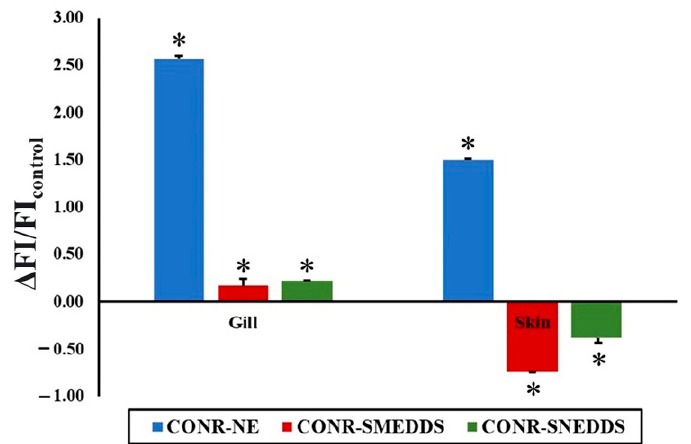
Figure 2. Fluorescence microscopy images of CONR-EtOH ( A ), CONR-NE ( B ), CONR-SMEDDS ( C ), and CONR-SNEDDS ( D ) accumulated in external and internal organs of transparent zebrafish: head (1), gill (2), gill filament (3), skin (4), and brain (5). These illustrations are demonstrated for qualitative determination.